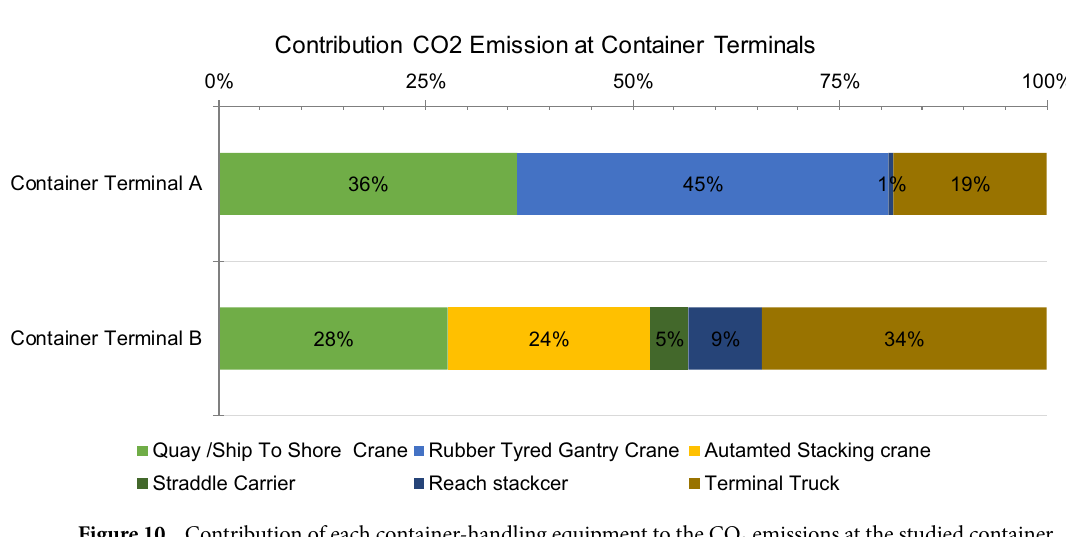
Figure 10. Contribution of each container-handling equipment to the CO 2 emissions at the studied container